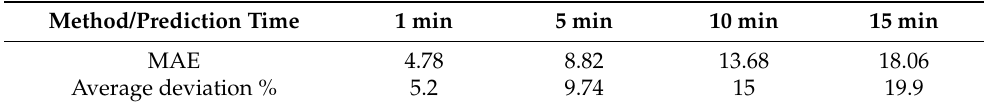
Figure 8. Test dataset input parameters. Table 2. Mean absolute error (MAE) and average variation between the actual and predicted coarse return on the test dataset.